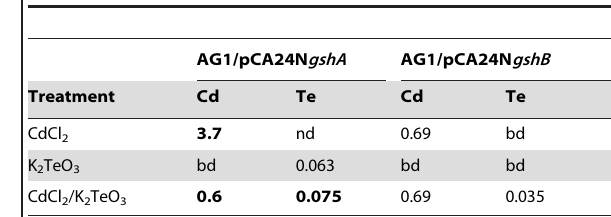
Table 1. Cd and Te content of E. coli expressing gshA or gshB